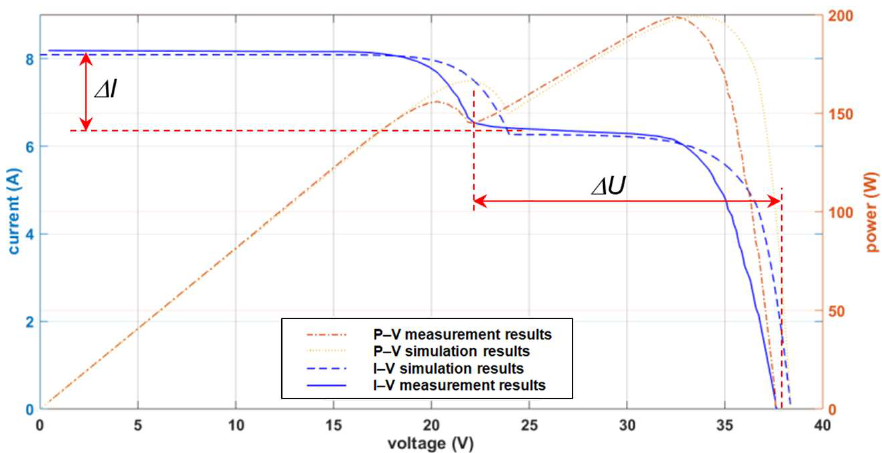
Figure 5. Verification results for measuring point P2 (see Table 2).